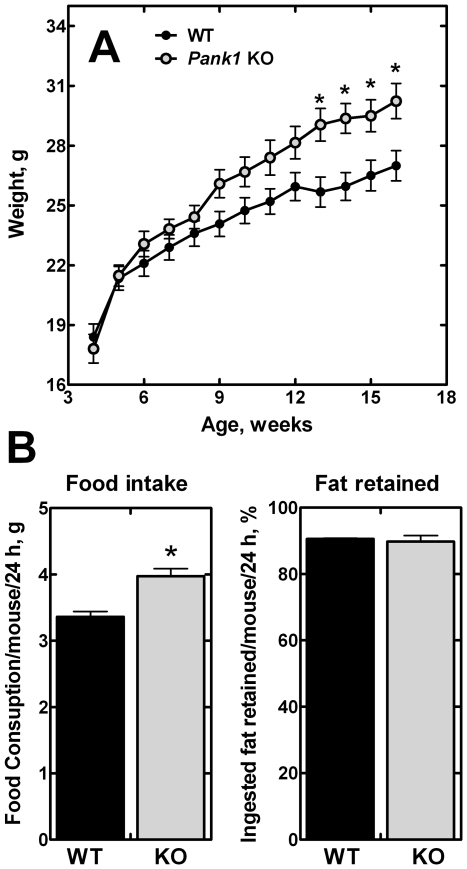
Weight monitoring and food intake in Pank1 knockout mice.(A) Body weight as a function of age was measured in 11 wild-type (WT) and 16 knockout (KO) mice. (B) Food intake: food consumption was monitored in 16 wild-type (WT) and 11 knockout (KO) mice. Fat retained: the percentage of fat retained by 4 wild-type (WT) and 8 knockout (KO) mice. 100% corresponds to 200 mg of lipids retained/mouse/24 hours for WT, and 276 mg of lipids retained/mouse/24 hours for KO. These data were calculated from the measured amount of lipid ingested minus the measured amount of lipid excreted in the feces. Statistically significant differences between wild-type and knockout are indicated by * (p<0.05).